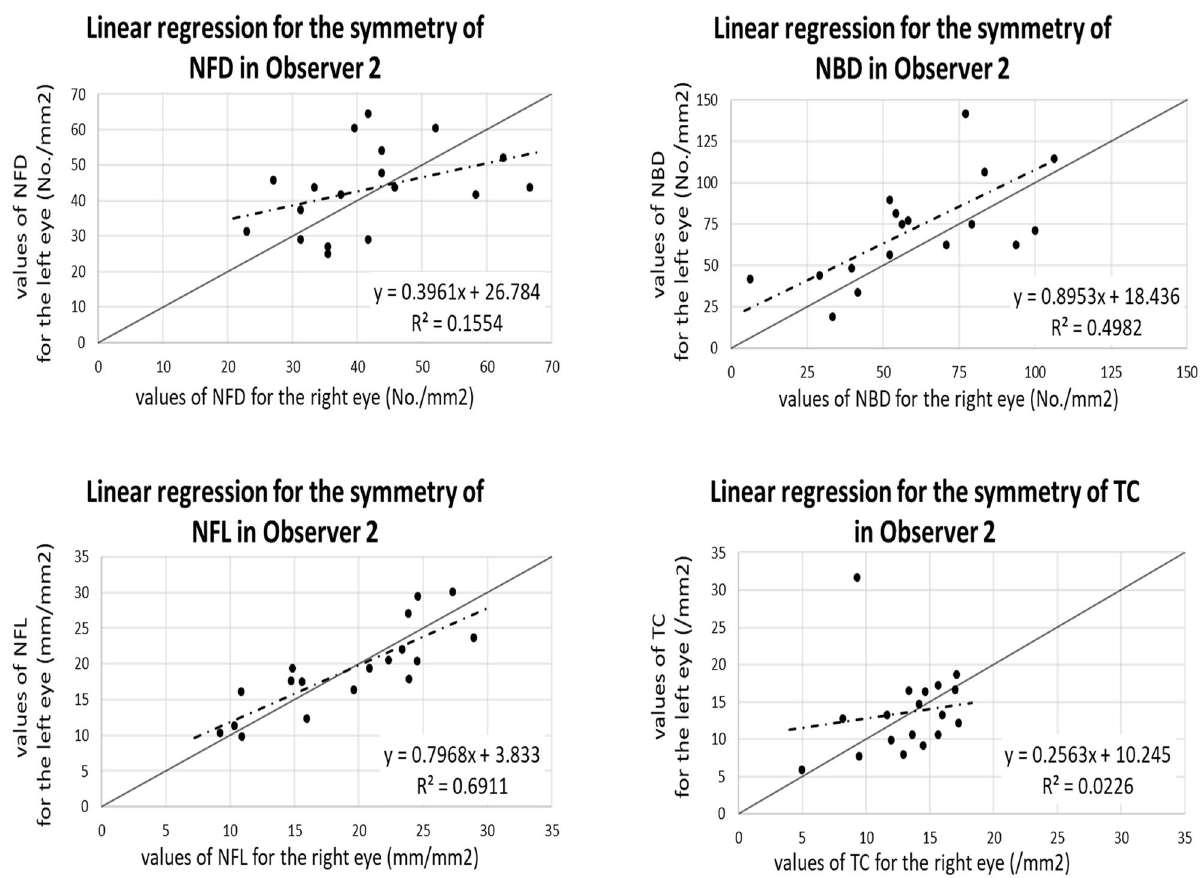
Figure 3. Regression plots of each sub-basal corneal nerve plexus parameters between the right eye and left eye in observer 2 using CCM. Solid in each plot represents the equivalence line while dotted line in each plot represents the Spearman regression line. NFD nerve fiber density, NBD nerve branch density, NFL nerve fiber length, TC tortuosity coefficient.